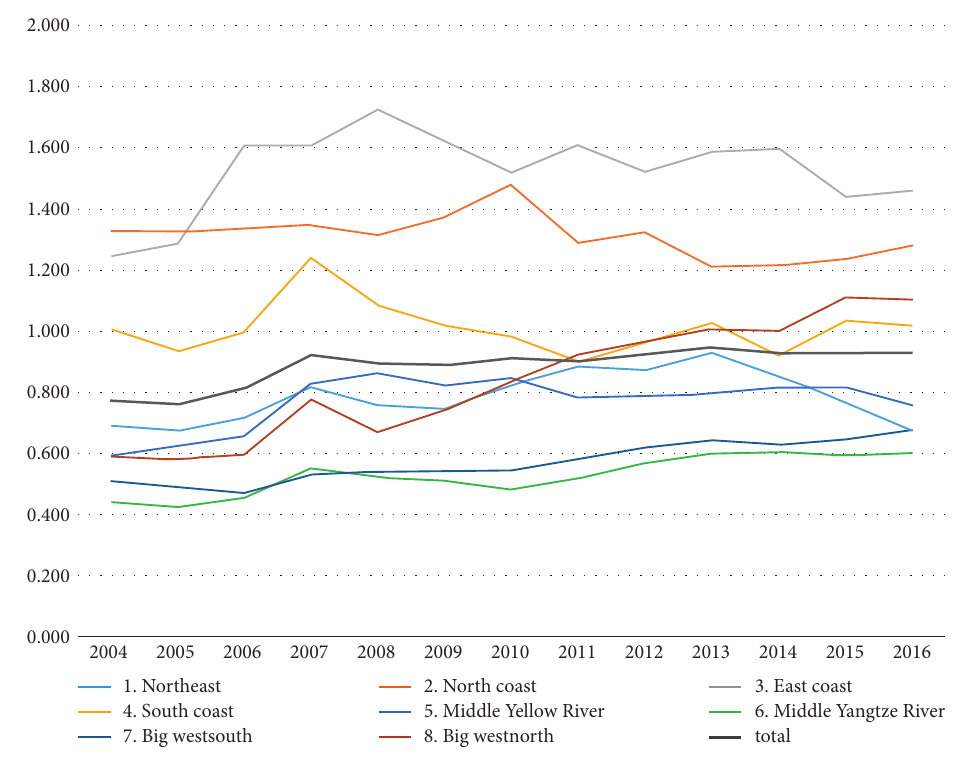
Figure 2: Ranges of the three-stage SE financial efficiency in the eight economic zones covering the period from 2004 to 2016.